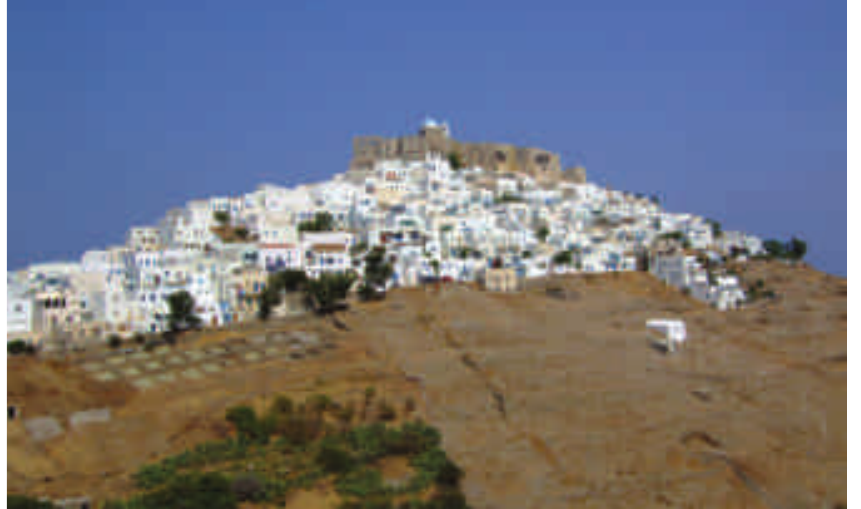
Figure 3 Photograph of the 2008 trench, with exposed Roman and “intermediate’”structural phases highlighted (Blue: Roman “store-building”; Green: alterations to “store-building”; Yellow: intermediate